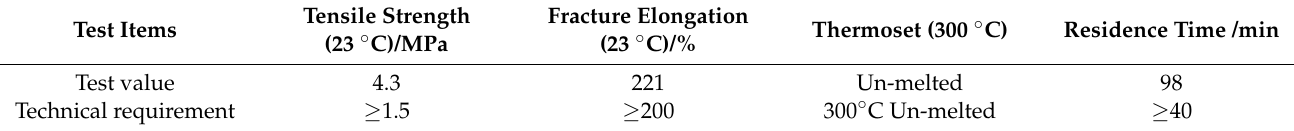
Table 3. Performance indexes of epoxy